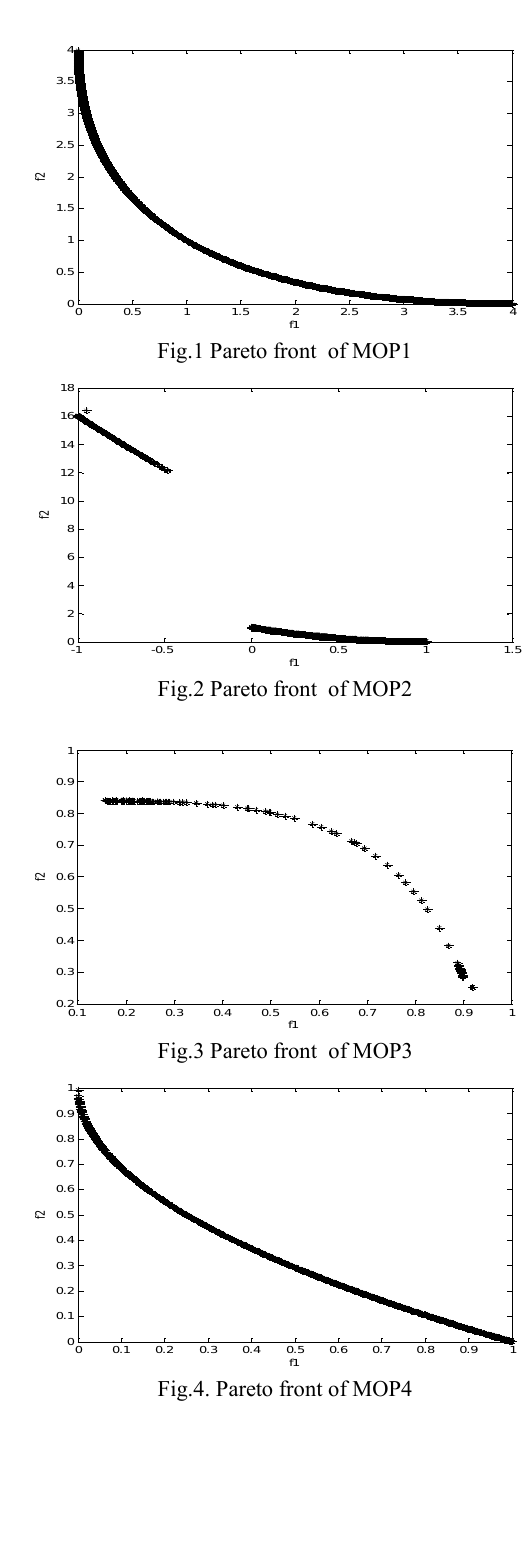
Fig.4. Pareto front of